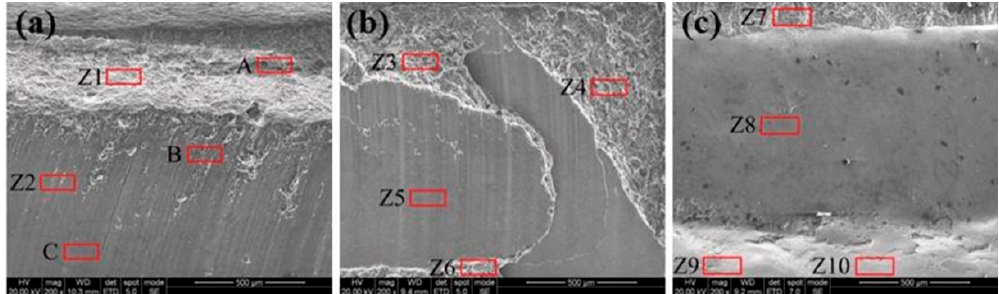
Figure 4. SEM images of fracture: (a) Joint #5; (b) Joint #9; (c) Joint #14. Table 4. EDS results of P1–P6 points in Figure 2d and Z1–Z10 regions in Figure 4. Chemical Composition (at%) Zones Probable Phase Ti Al V Mg P1